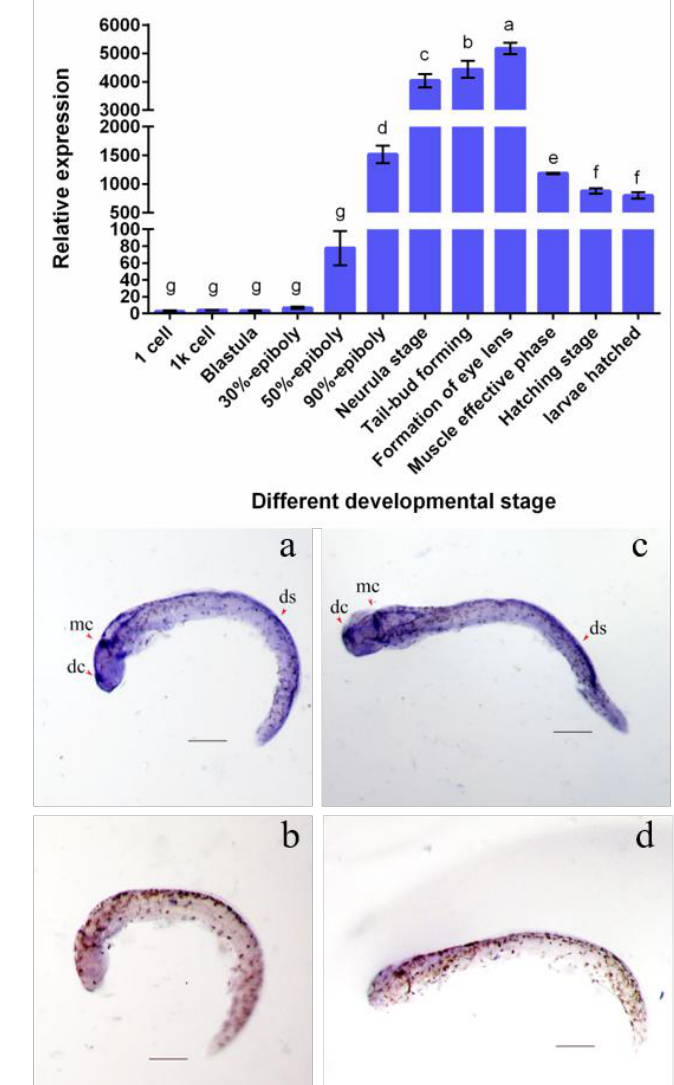
Figure 3. The spatiotemporal expression pattern of C. semilaevis Rspo3 . ( A ) Expression profiles of Rspo3 mRNA at different embryonic developmental stages. B2M is the reference gene. The data are shown as mean ± standard deviation (SD) (number of replicates, n = 3; number of total samples analyzed in each group, N = 90). Values with different superscripts indicate different statistical significance ( p < 0.05); ( B ) Whole-mount in situ hybridization (WISH) analysis of Rspo3 mRNA at tail bud stage. The embryos are shown in lateral (a and b) and quarter (c and d) views, with anterior to the left. Scale bars = 200 μm; a and c correspond to anti-sense probes, b and d to sense probes. dc: diencephalon; mc: metencephalon; ds: dorsal stripe.